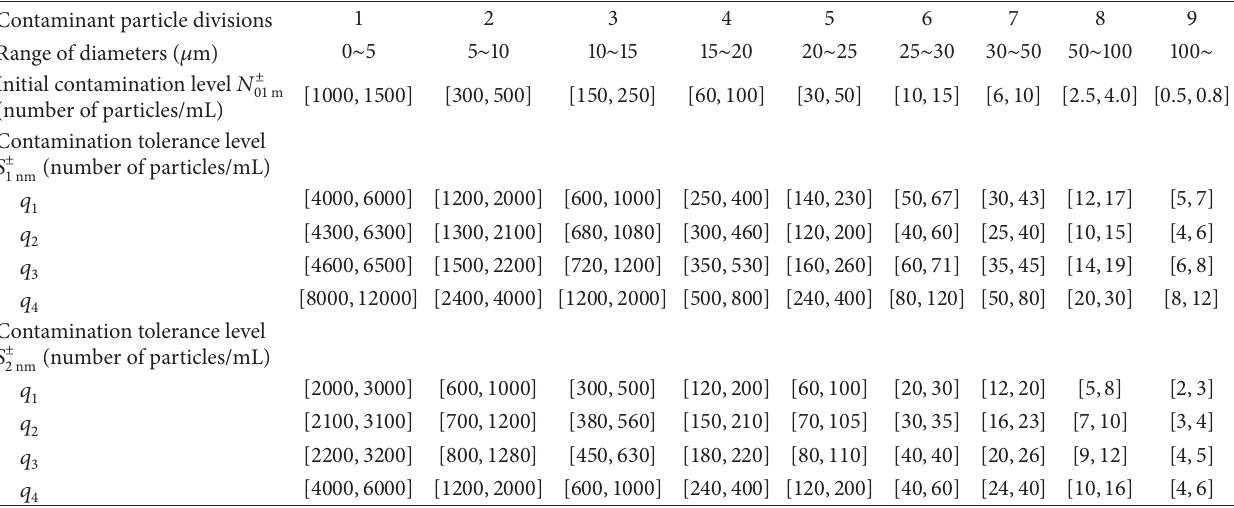
Table 2: Particle diameters, initial contamination, and contamination tolerance levels.